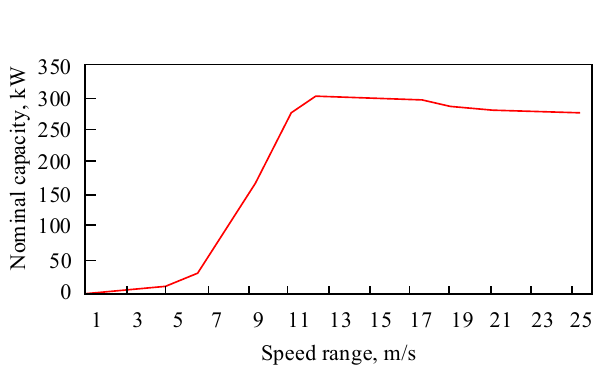
Fig. 5. Power curve of NTK 300 wind